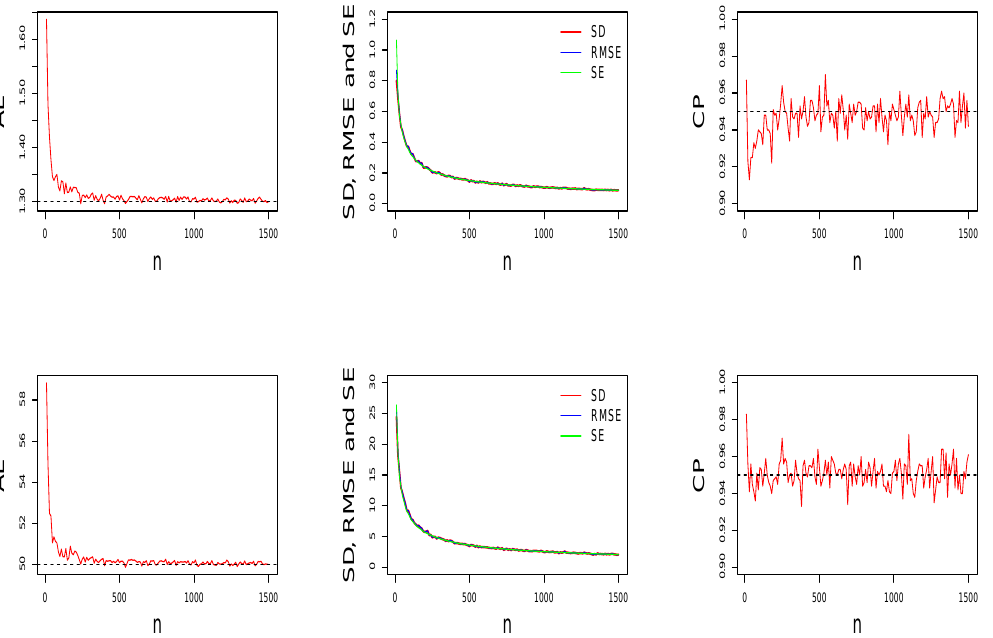
Figure 6. The AE, SD, RMSE, SE, and CP for each of the 1000 estimates of α ( top ) and β ( bottom ) obtained in scenario C, under the different sample